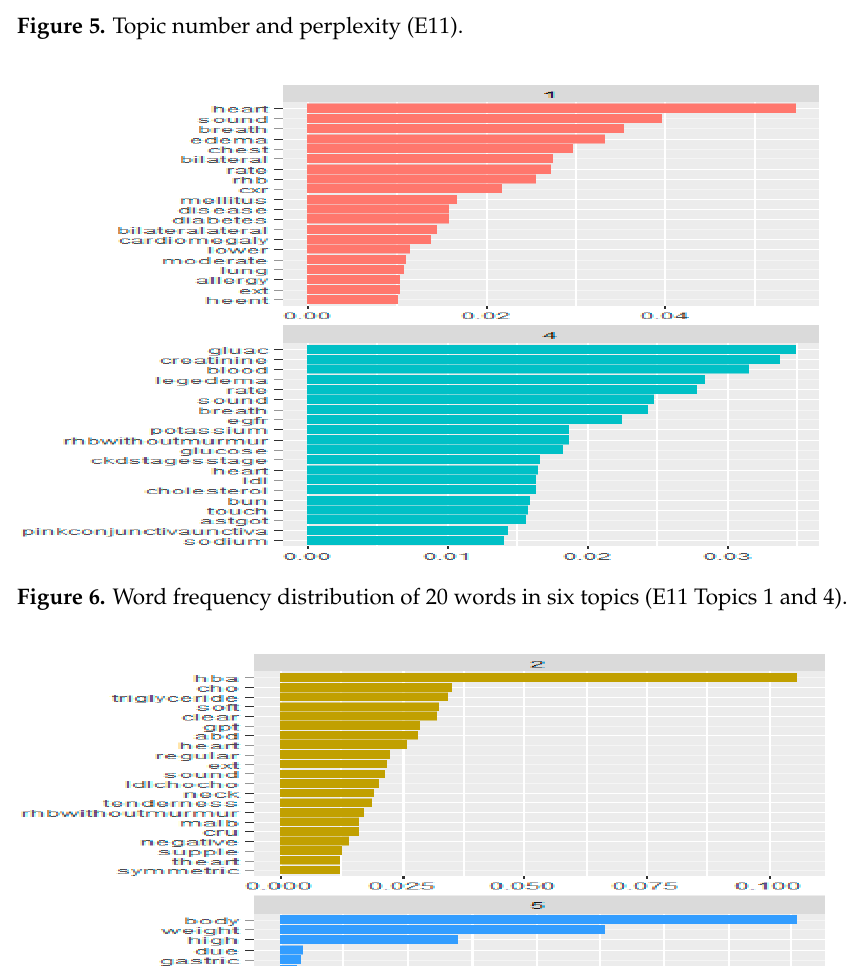
Figure 5. Topic number and perplexity (E11).